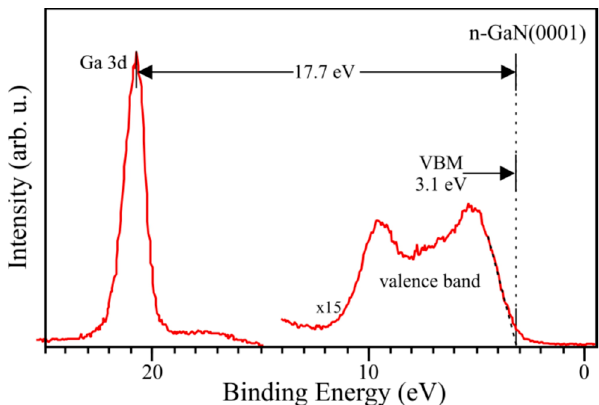
Figure 8. XPS measurement of an n ‐ GaN(0001) sample. Visible Ga ‐ 3d electron state and valence band. Reprinted with permission from [64]. Copyright 2020 Elsevier.